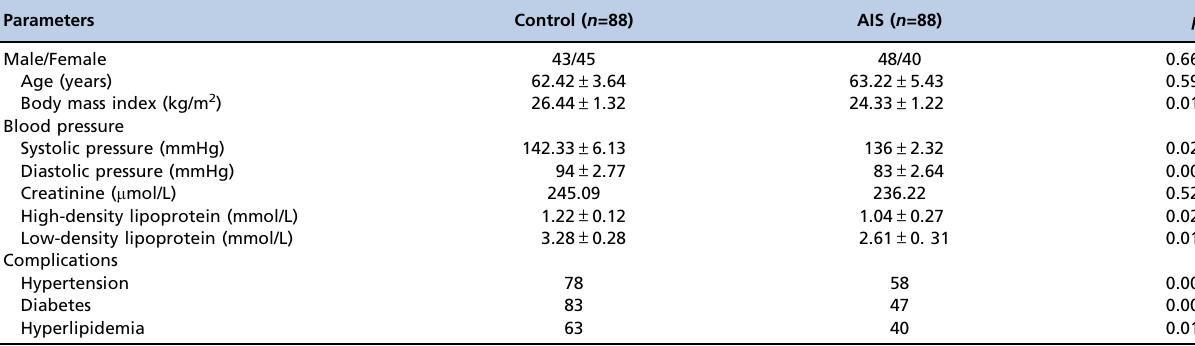
Table 1 - General baseline information of the study participants.